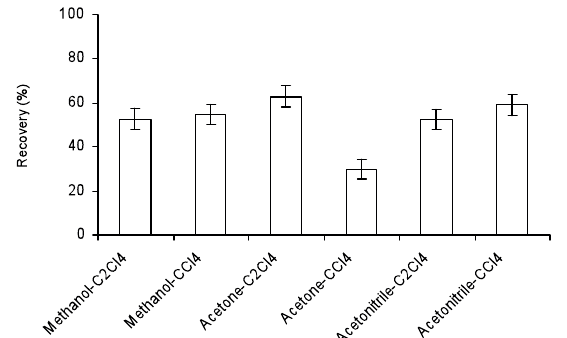
Figure 3. Effect of extraction solvent volume on volume of sedimented phase (analyte concentration 1 mg L -1 , volume of disperser solvent was 1 mL, pH = 3, n = 3).